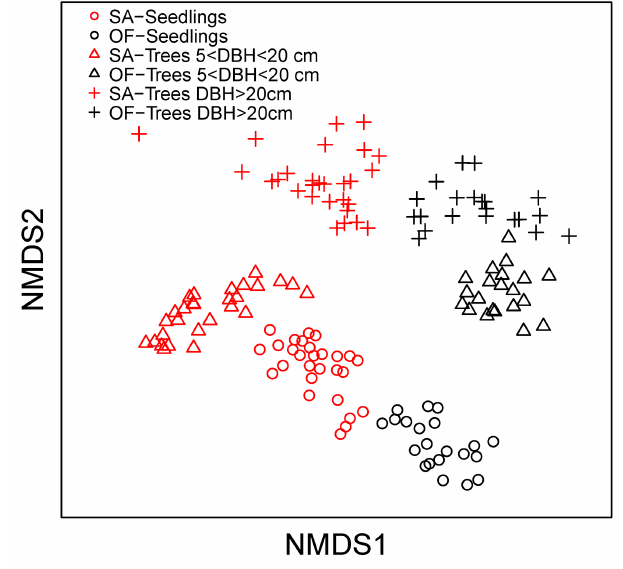
Fig. 2 . Nonmetric multidimensional scaling (NDMS) showing differences in floristic composition between sacred agroforests (SA) and old fallows (OF) in different strata: seedlings, trees with 5 < DBH < 20 cm (middle strata) and trees with DBH > 20 cm (upper strata). Each point in the graph represents a transect, and distances between points are proportional to their biological dissimilarity, calculated with the Bray-Curtis